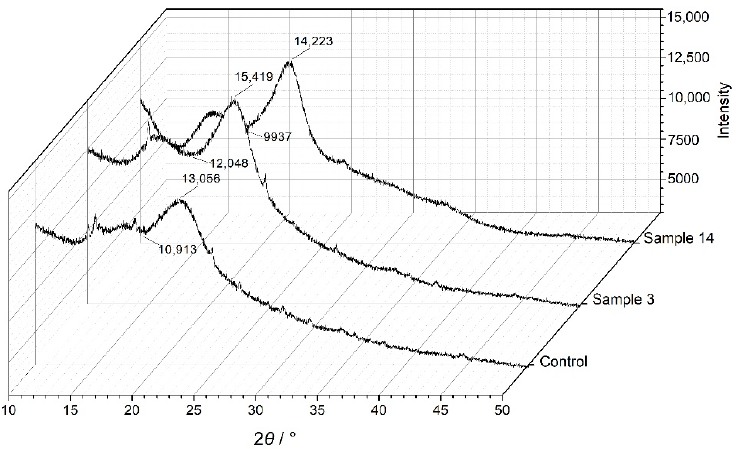
Figure 3. XRD patterns of rice straw samples before and after LHW and LHW-PTA pretreatment.